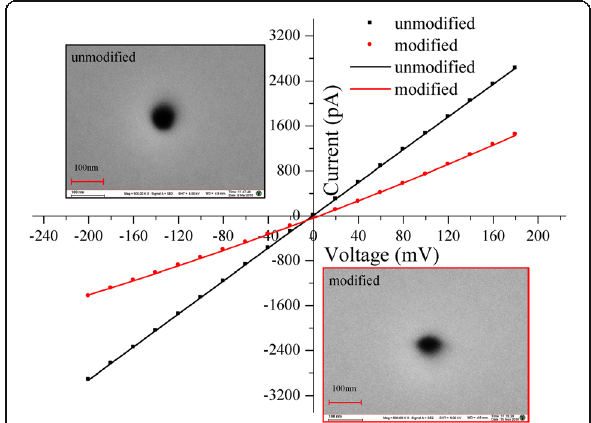
Fig. 2 Performing a typical current-voltage ( I-V ) curves of the unmodified (original) and modified nanopore in 0.1 M KCl, buffered at pH 7.0 with 0.1 M PBS. The black line is the I-V curves of unmodified nanopore, and red line is the I-V curves of modified nanopore with HRPs. The inserts are the scanning electron microscopy (SEM) of a single nanopore (diameter of ~50 nm cis) and the nanopore sensor. 100 nm is